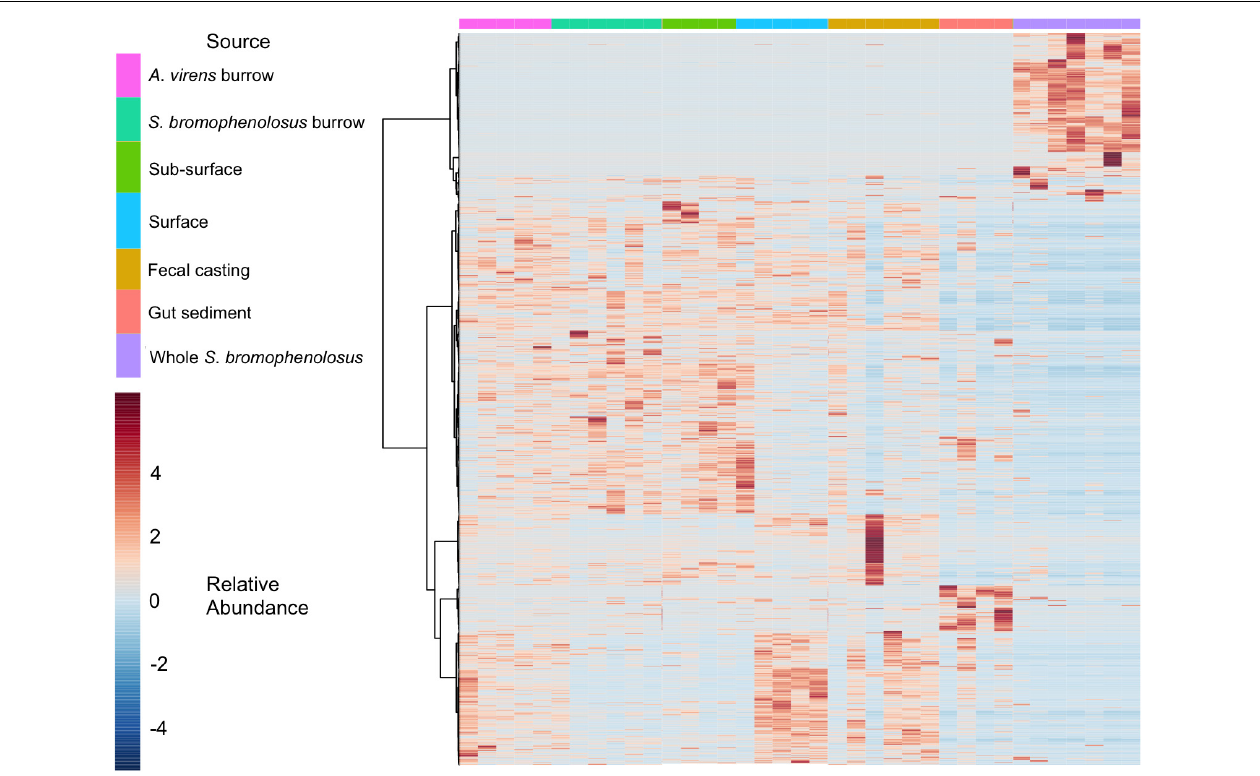
FIGURE 4 | Heatmap of animal and sediment microbial communities. Heatmap of OTU relative abundances observed for individual S . bromophenolosus , gut and sediment samples. Pearson’s correlation coefficient was used as a distance metric, with clustering based on Ward’s algorithm as implemented by MicrobiomeAnalyst (Dhariwal et al.,